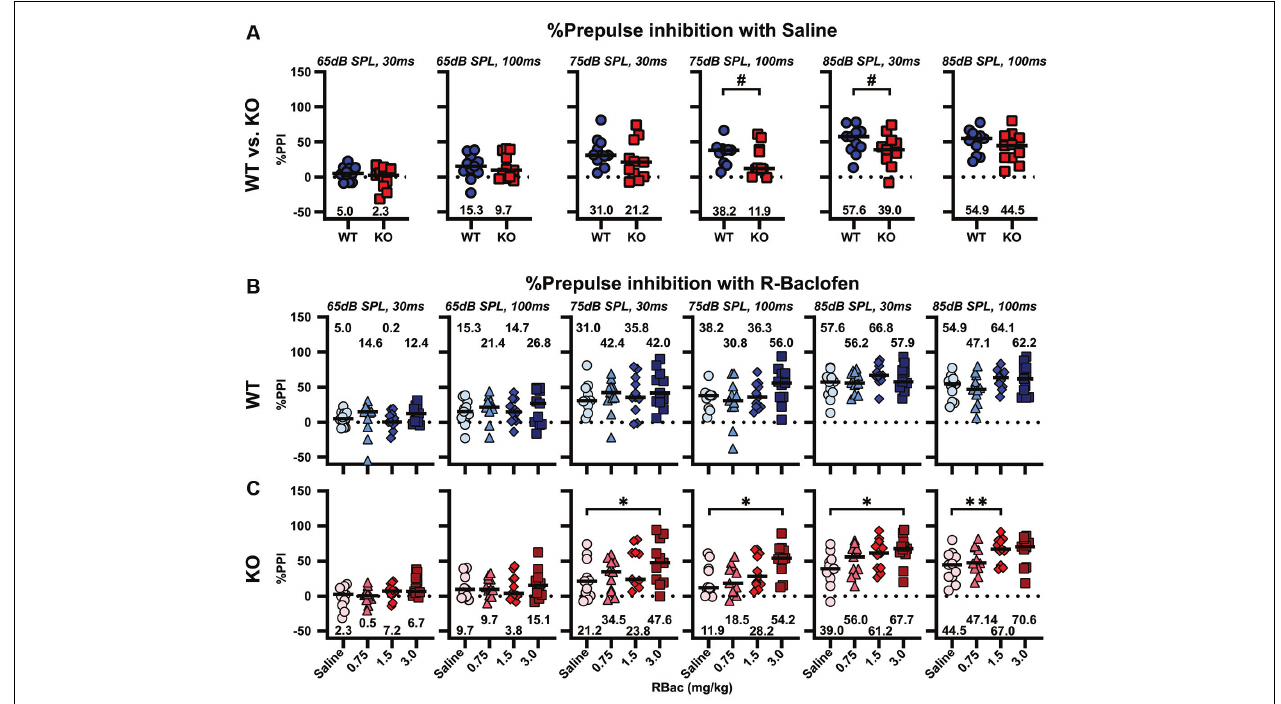
FIGURE 8 | R-Baclofen increases the relative amount of PPI (%PPI) in Cntnap2 KO rats. (A–C) %PPI was elicited by six different prepulse conditions with three stimulus levels at two different ISIs (from left to right: 65 dB SPL, 30 ms; 65 dB SPL, 100 ms; 75 dB SPL, 30 ms; 75 dB SPL, 100 ms; 85 dB SPL, 30 ms; 85 dB SPL, 100 ms). Scatter plots depict individual %PPI for each prepulse condition and black horizontal lines represent the median %PPI. (A) %PPI for each prepulse condition in Cntnap2 WT (blue circles) and KO rats (red squares) after saline injection. Cntnap2 KO rats had consistently, but statistically nonsignificant, lower %PPI than WT rats. Estimated p values of p = 0.0017 and p = 0.0163 indicate a significant PPI deficit in Cntnap2 KO rats for prepulses with 75 dB SPL, 100 ms, and 85 dB SPL, 30 ms (for statistical comparisons and estimated p values through resampling see Table 5 ). (B) There were no significant differences in %PPI in Cntnap2 WT rats between saline (circles), and 0.75 mg/kg (light blue triangles), 1.5 mg/kg (blue diamonds), and 3 mg/kg R-Baclofen (dark blue squares) for any of the six prepulse conditions (for statistical comparisons see Table 6 ). (C) In Cntnap2 KO rats, %PPI was significantly increased through R-Baclofen (0.75 mg/kg: light red triangles, 1.5 mg/kg: red diamonds, 3 mg/kg R-Baclofen: dark red squares) compared with saline (circles), in particular with prepulses of 75 dB SPL, 30 ms; 75 dB SPL, 100 ms; 85 dB SPL, 30 ms (3 mg/kg); and 85 dB SPL, 100 ms (1.5 mg/kg). For statistical comparisons see Table 6 . Dotted horizontal lines at 0%PPI represent no PPI of the startle. ∗ p < 0.05; ∗∗ p < 0.01; # p < 0.05 estimated p- value through